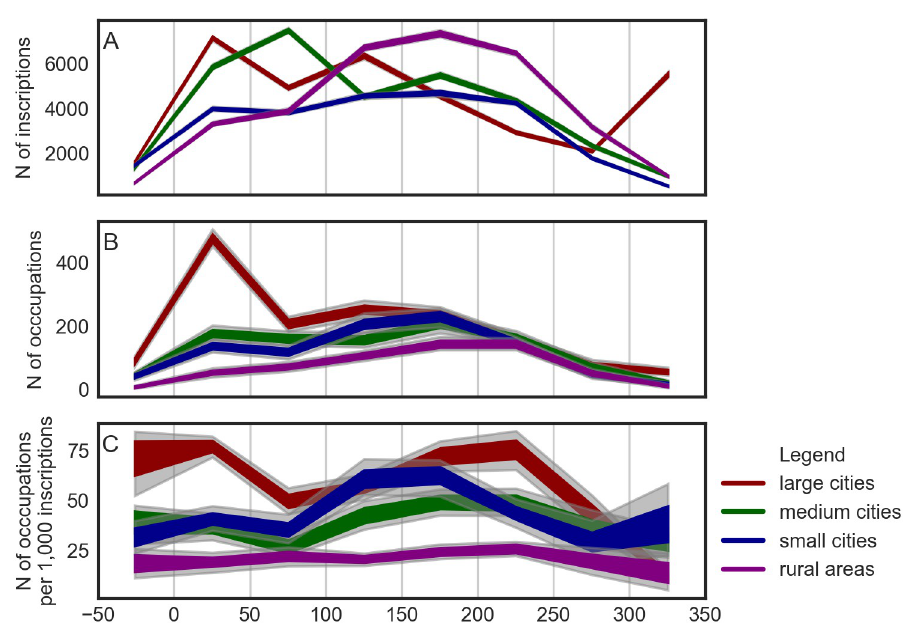
Fig 5. Temporal distributions of inscriptions and occupations using uniform 50-years-long timeblocks. A— temporal distributions of inscriptions; B—temporal distributions of occupations; C—temporal distribution of occupations per 1,000 inscriptions. Gray color represents data from the underlying time series out of the 95% confidence interval.